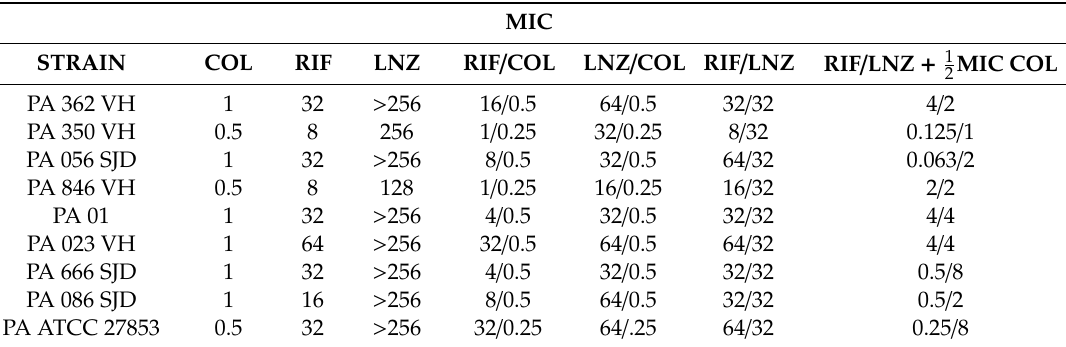
Table 3. MICs according to EUCAST [16] in MDR P. aeruginosa strains.